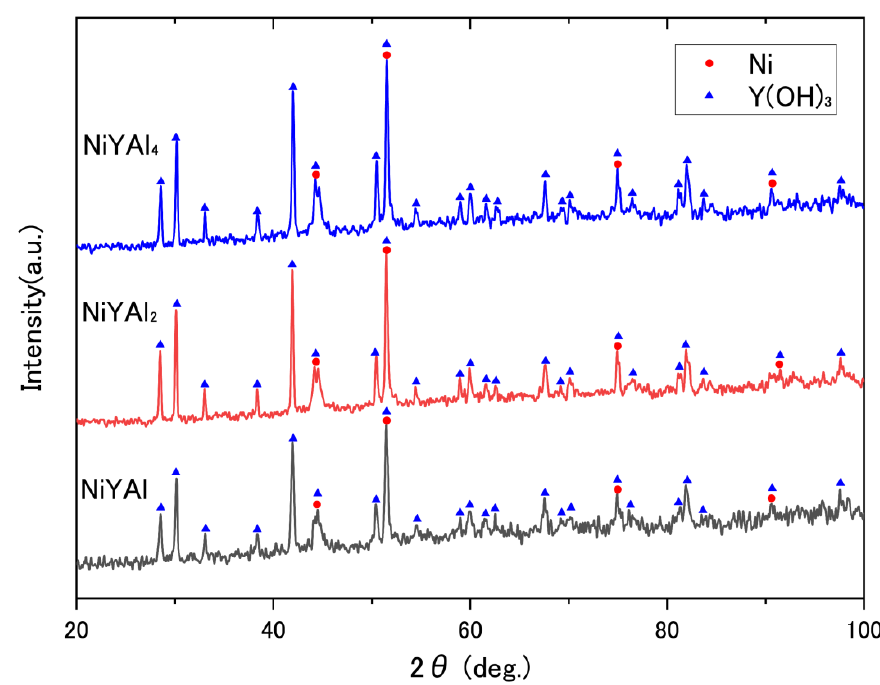
Figure 2. X-ray diffractograms of the nanoporous catalysts obtained from NiYAl 4 , NiYAl 2 , and NiYAl intermetallic precursors.